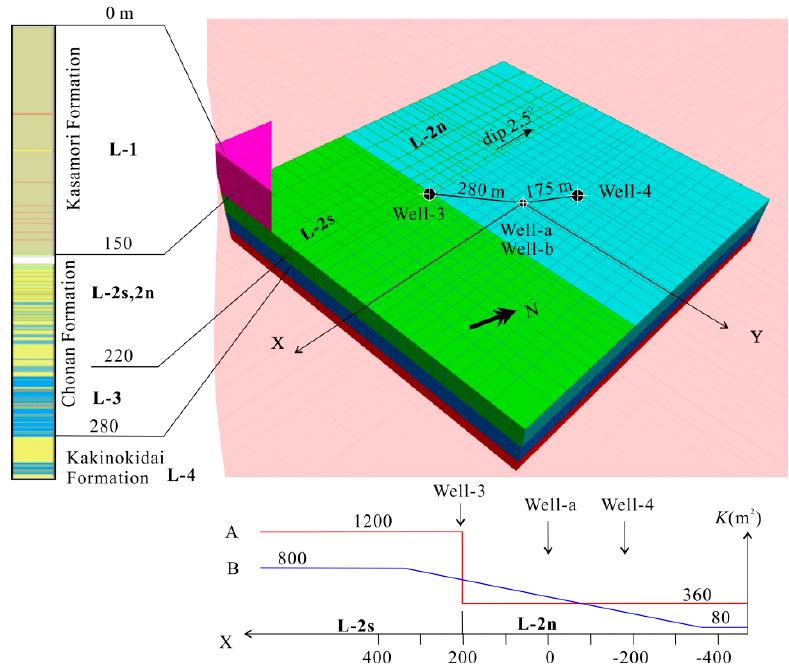
Figure 8. Geological and numerical models for simulation of the pumping tests at Well-3 and Well-4.